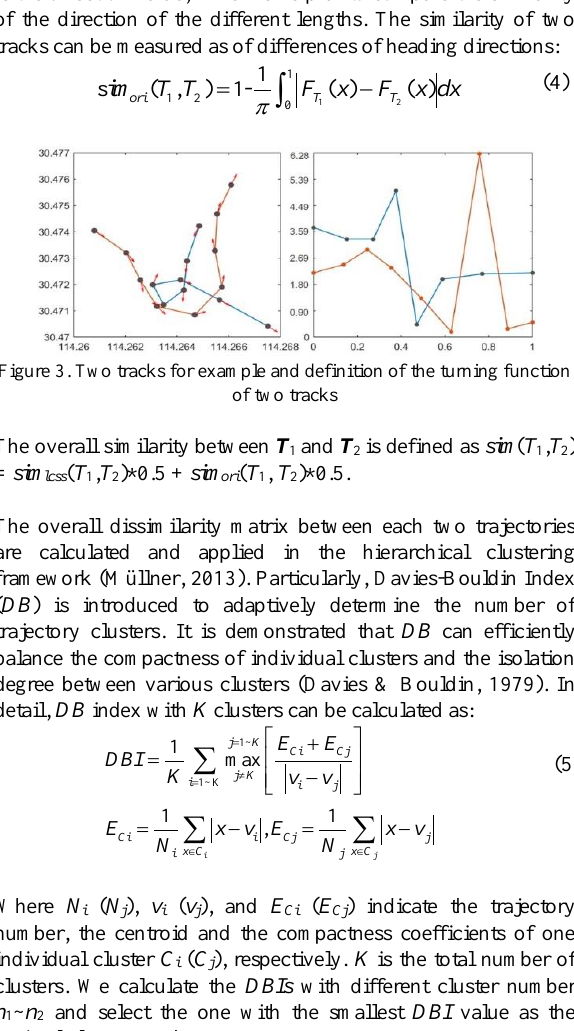
segment fitting algorithm of Verbeek et al. (2002) is implement